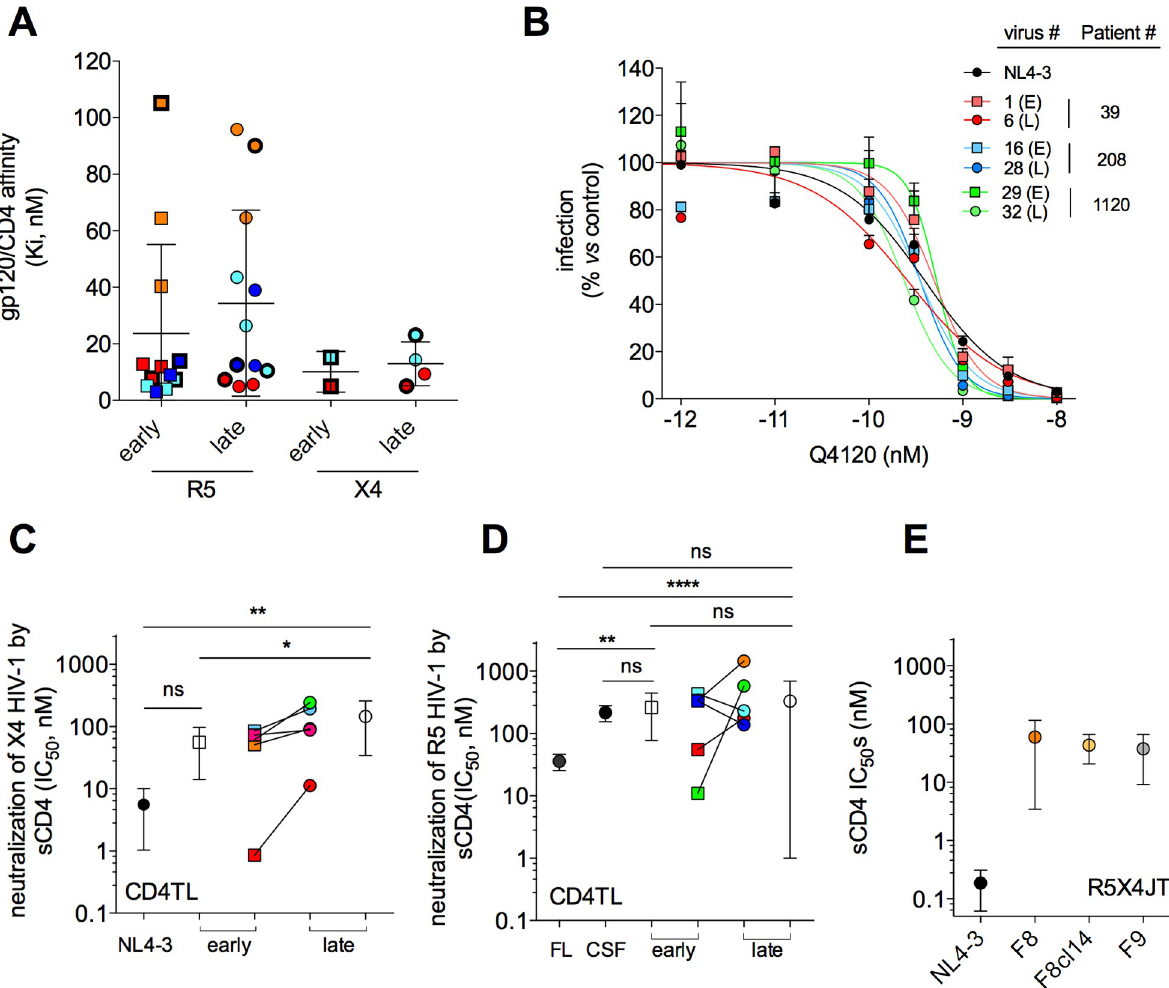
Fig 2. Resistance to CXCL12 is not due to improved Env/CD4 interactions. A Equilibrium dissociation constants Ki of interactions between CD4 and early or late R5 or X4 gp120s. Each data point is the mean Ki value for a given gp120. Color code: R5 gp120s: Red, P#1 (Early (E): # 1 , 2, 3; Late (L): # 10 , 11, 12); Light blue, P#341 (E: # 25 , 26, 27; L: # 34 , 35, 36); Orange, P#458 (E: # 37, 38 , 39; L: 46, 47, 48 ); Dark blue, P#1031 (E: # 49, 50 , 51; L: # 58 , 59, 60). X4 gp120s: Red, P#39 (E: # 1 ; L: # 6 , 7); Light blue, P#208 (E: # 16 ; L: # 27, 28 ). Symbols in bold refer to gp120s from the Envs shown in Fig 1A and 1B . Error bars are SEM. B Inhibition by mAb Q4120 of infection of CD4TL with viruses pseudotyped with early (E) or late (L) Envs. Results are expressed as percent infection relative to control infection in the absence of Q4120. One representative experiment is shown (error bars: SEM). C IC 50 s for neutralization by sCD4 of infection of CD4TL with viruses pseudotyped with the early or late X4 Envs shown in Fig 1A . Mean ( ± SD) (open symbols) and individual (colored symbols) IC 50 s are shown. D Neutralization by sCD4 of the R5 Envs shown in Fig 1B . JR-FL and JR-CSF Envs were included as controls. E Neutralization by sCD4 of F8, F8 cl. 14, F9 and NL4-3 Envs. Results are means ± SD of experiments on R5X4JT cells.